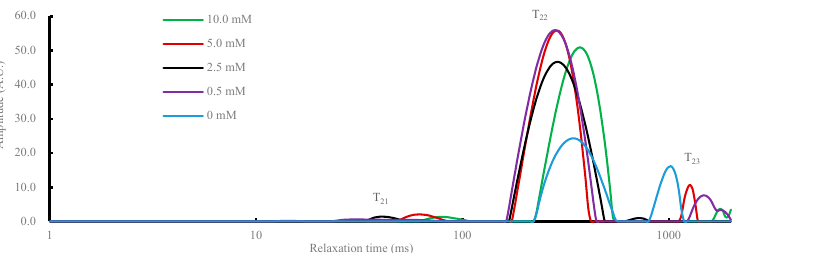
Figure 6. Effect of different malondialdehyde concentrations (0, 0.5, 2.5, 5.0, and 10.0 mmol/L) on the distribution of the T 2 of duck myofibrillar proteins gel. T 2 = spin–spin relaxation times (ms) for different types of water.